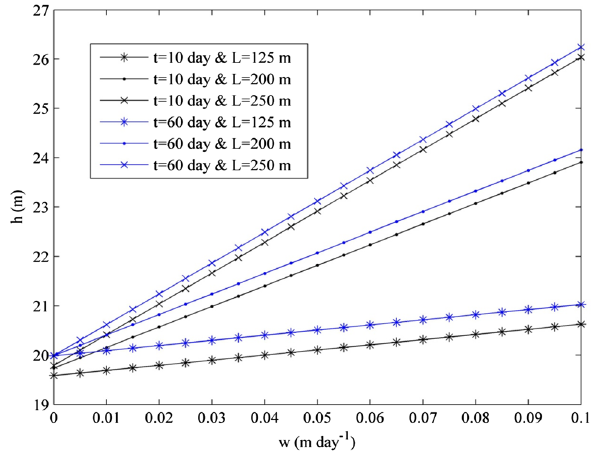
Fig. 8 Variation in hydraulic heads due to changes in recharge rate with different values of specific storage